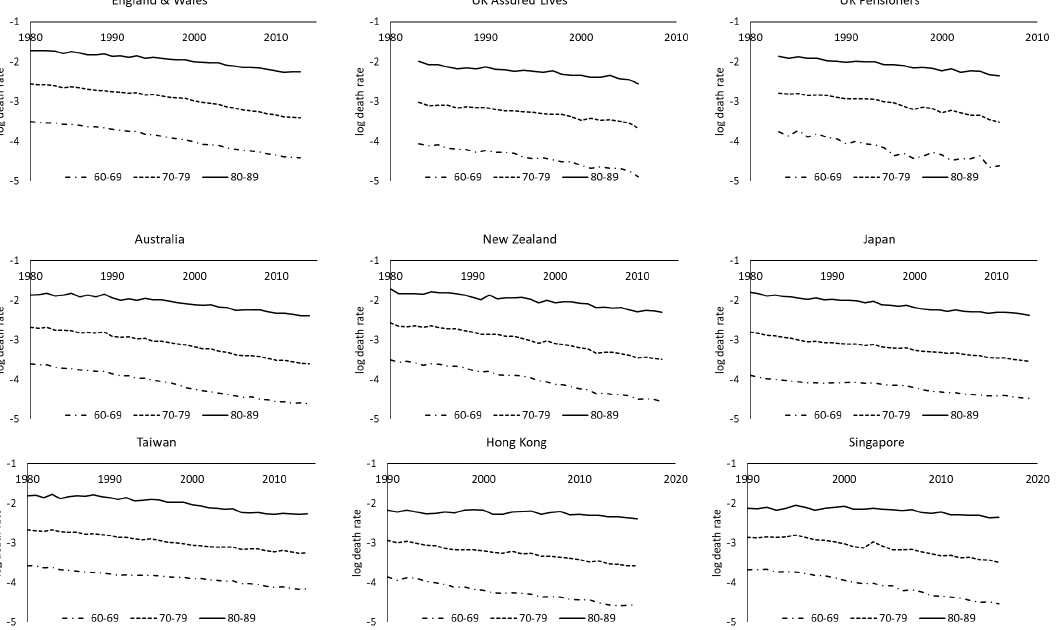
Figure 3. Log central death rates of male lives in UK and Asia–Pacific regions, 1980–2016.